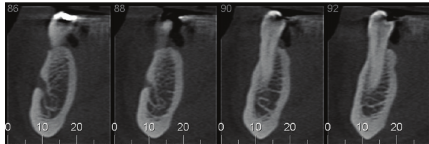
Figure 1: Image defined as being the incisive canal of the mandible [MIC].